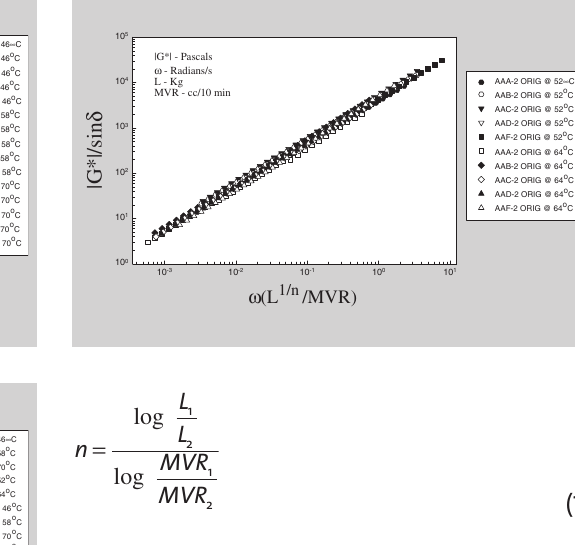
Figure 2a (left above): Uni- fied curve of the SHRP para- meter |G*|/sin d with modi- fied frequency w (L1/n/MVR) covering the temperature range of 46˚C - 70˚C for five asphalts (AAA-1, AAB-1, AAD-1, AAF-1 and AAM-1) each in original unaged forms. Figure 2b (right above): Uni- fied curve of the SHRP para- meter |G*|/sin d with modi- fied frequency w (L1/n/MVR) at temperatures of 52˚C and 64˚C for five asphalts (AAA- 2, AAB-2, AAC-2, AAD-2 and AAF-2) each in original unaged form. Figure 3 (left below): Unified curve of the SHRP parame- ter |G*|/sin d with modified frequency w (L1/n/MVR) at temperatures of 46˚C, 58˚C and 70˚C for asphalt AAB-1 as well as at temperatures of 52˚C and 64˚C for asphalt AAB-2, each in original unaged and (RTFOT & PAV) aged